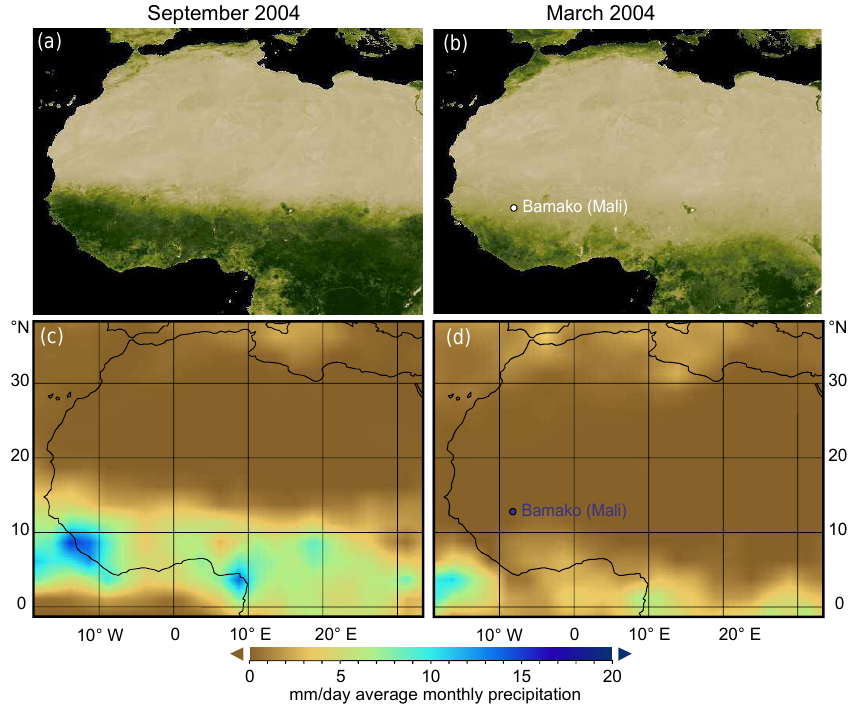
Figure 3. Seasonal extremes in vegetation ( a , b , NDVI, normalized difference vegetation index available at www.earthobservatory.nasa.gov) and rainfall ( c , d , precipitation in mm per day available at http://www.cdc.noaa.gov/) of northern and West Africa in September 2004 (a, c) vs. March 2004 (b, d)